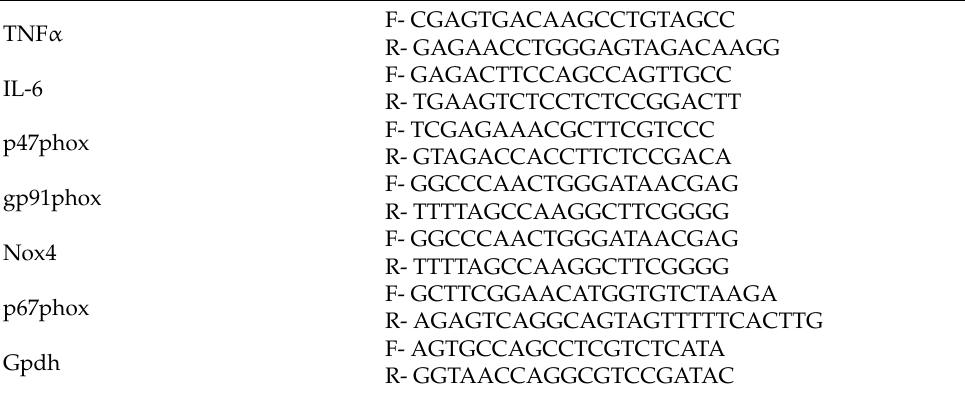
Table 1. Primer sequences of the target genes used in RT PCR